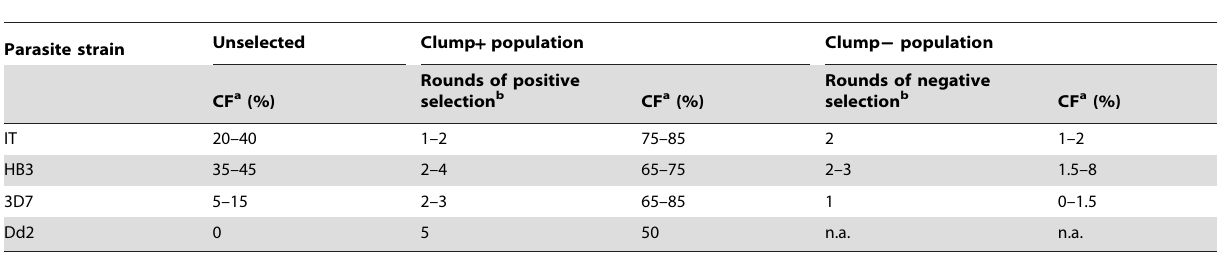
Table 1. Summary of clumping selection for four P. falciparum strains.